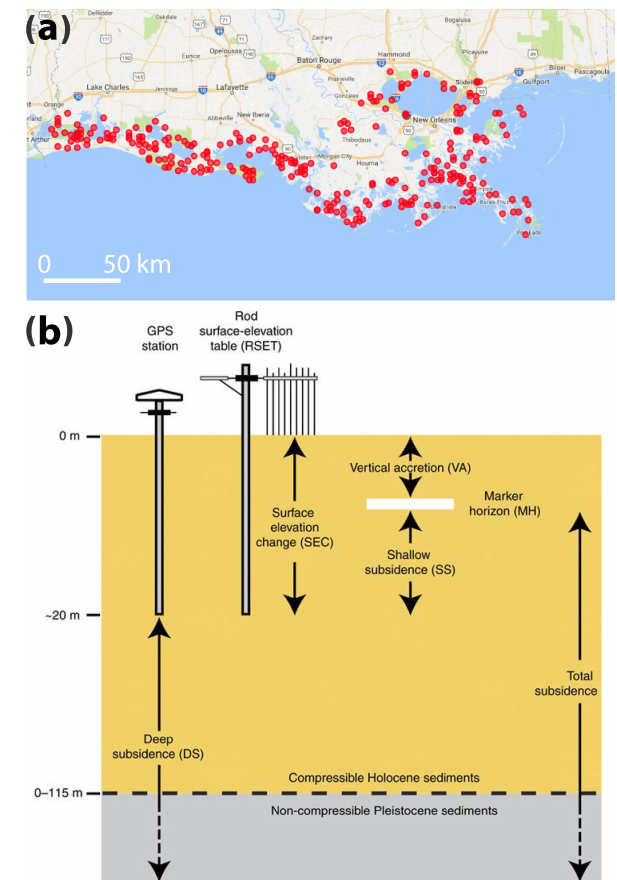
Figure 1. (a) Location of CRMS stations used to determine sub- sidence rates, at 274 sites along the Louisiana coast, based on data collected through the Coastwide Reference Monitoring System (CRMS) program. (b) Schematic of a CRMS-SET, including indi- cated range of deep subsidence (DS) and shallow subsidence (SS), reproduced from Jankowski et al. (2017).